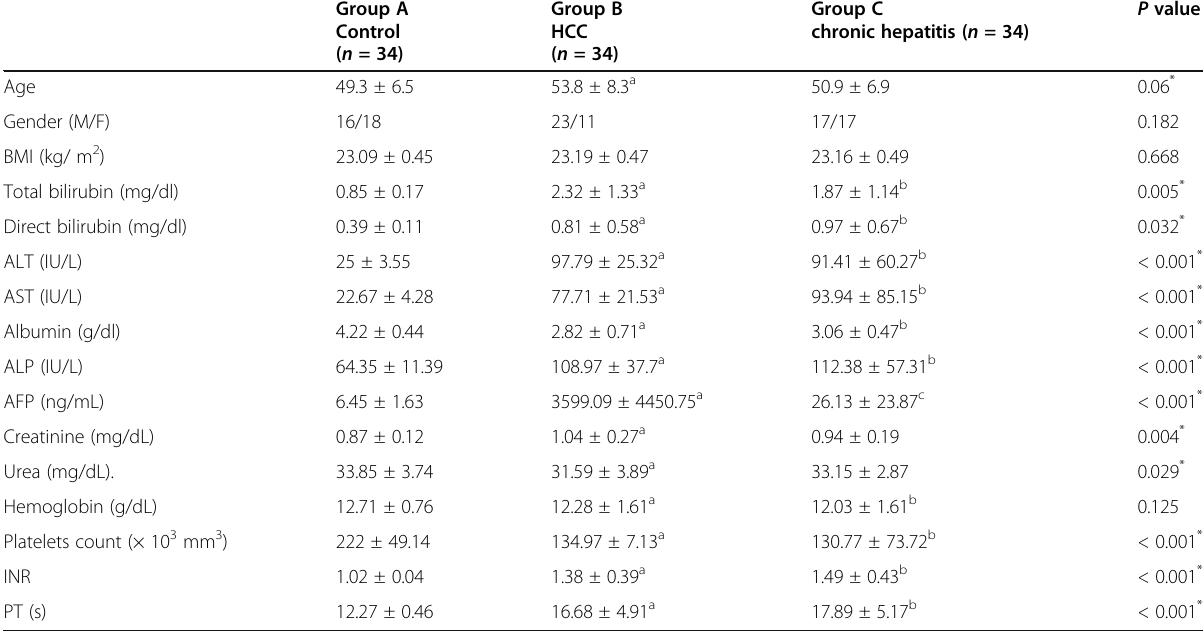
Table 1 Different biochemical data in the studied groups